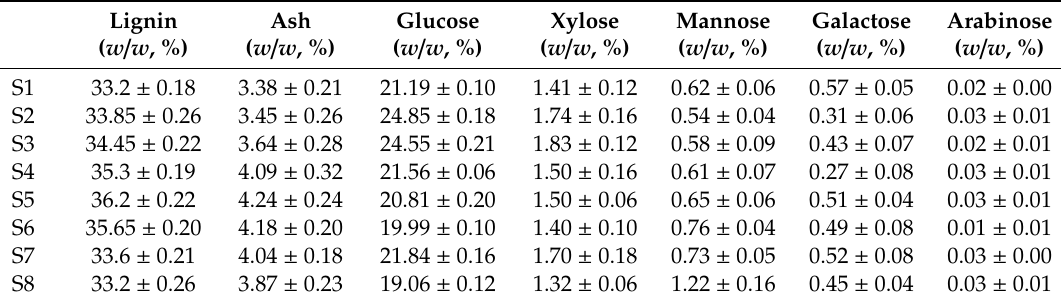
Table 3. The chemical composition of steam-exploded